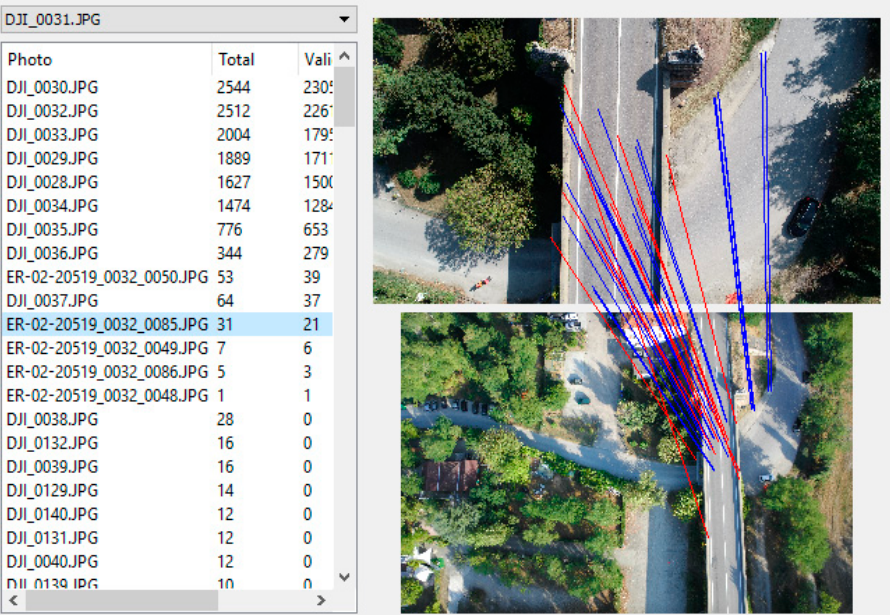
Figure 6. Efficiency of tie point extraction across auxiliary and master block. Left: total and valid number of matches between Phantom4 image 0031 (east bridge end) and the joint P4 30 and eBee block images. Right: valid (blue) and invalid (red) matches across Phantom4 image 0031 and eBee image 0032_0085.